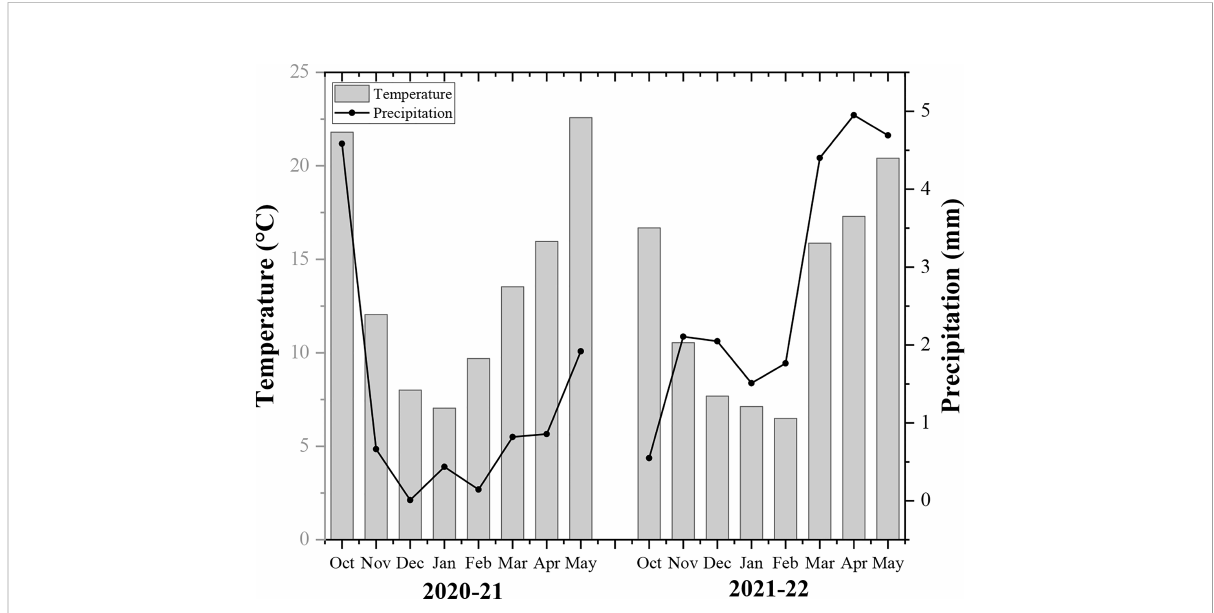
FIGURE 1 The monthly average temperature and precipitation of rapeseed growing seasons